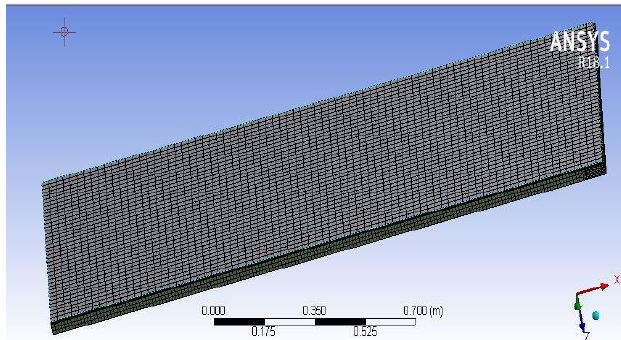
Figure 14. Mesh of a solid structure in the transient thermal simulation.